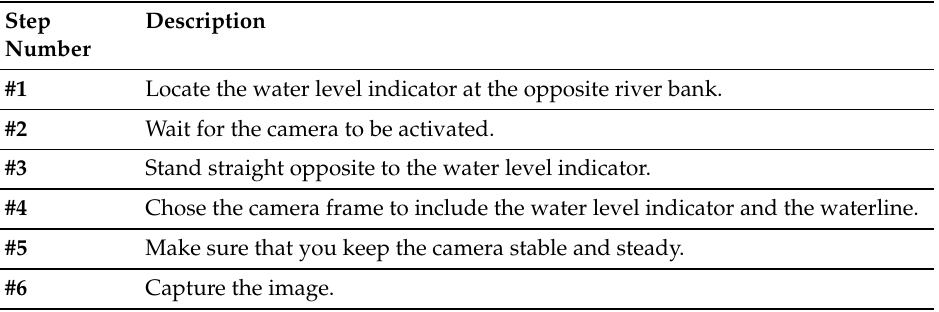
Table 2. Instructions for the water level indicator